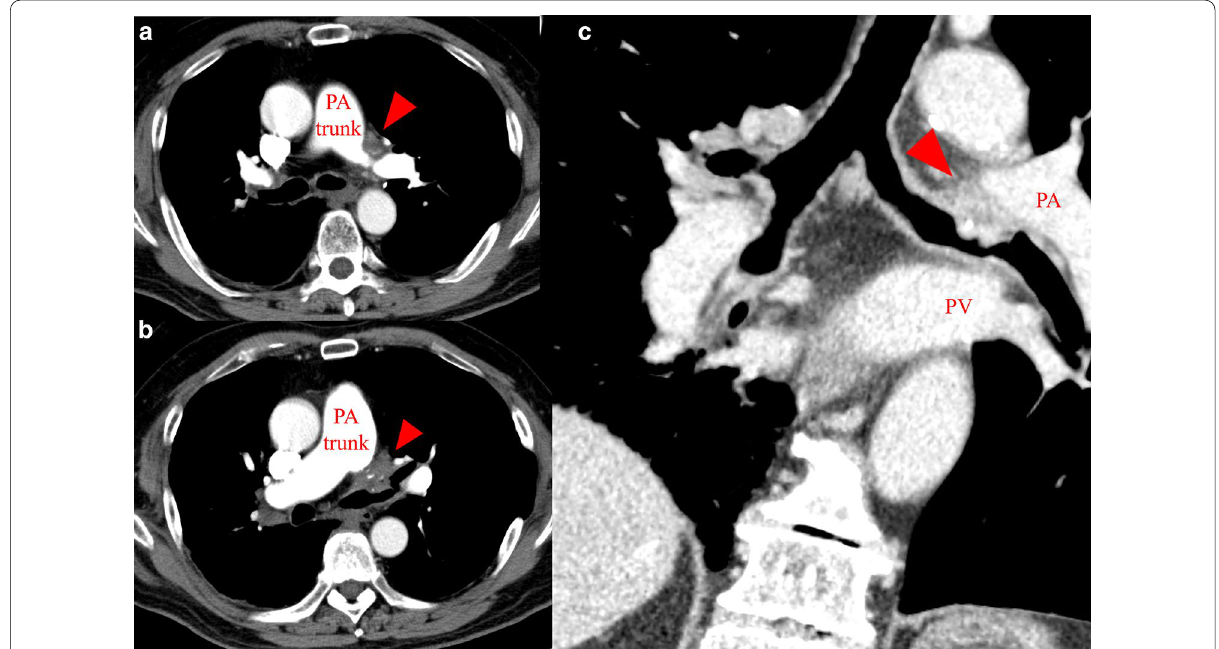
Fig. 2 Contrast-enhanced computed tomography images. a Main PA stenosis surrounded by the foreign body in the mediastinum (red arrowhead). b The foreign body protruding to the left main bronchus (red arrowhead). c A coronal section showing the foreign body between the PA and left main bronchus (red arrowhead). PA pulmonary artery, PV pulmonary vein